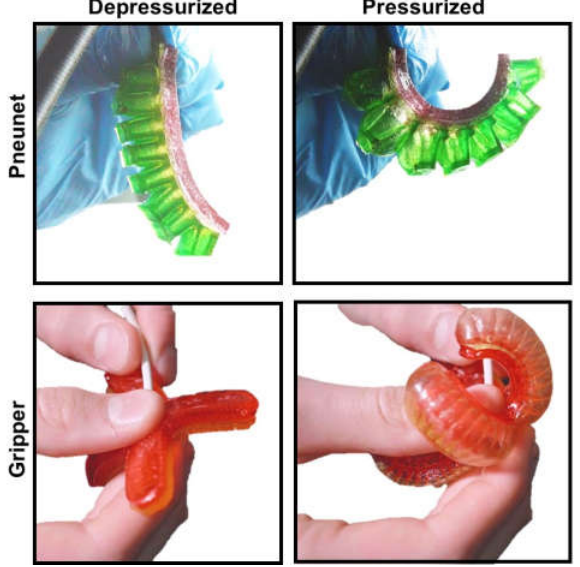
Figure 7. Gelatin based actuators cast as pnuenet fingers and grippers. Actuators can be pressurized with air to induce actuator bending and curling.